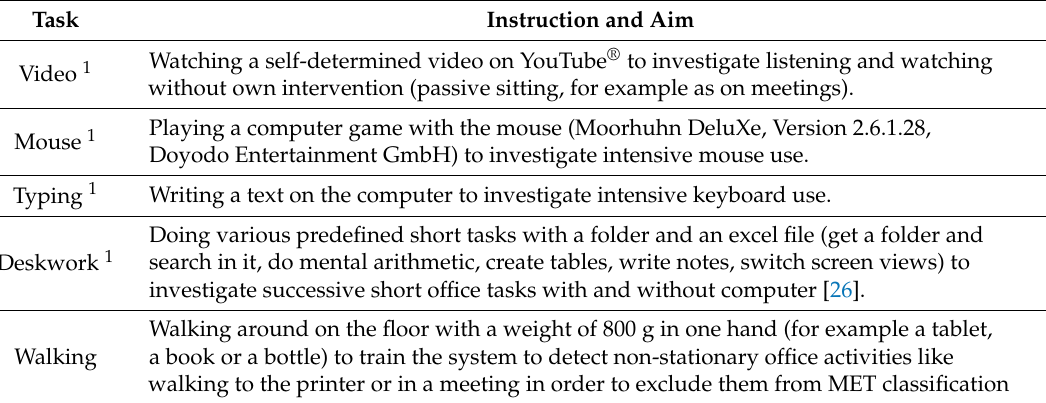
Table 1. Investigated office task. Task selection was based on previous studies investigating typical office work